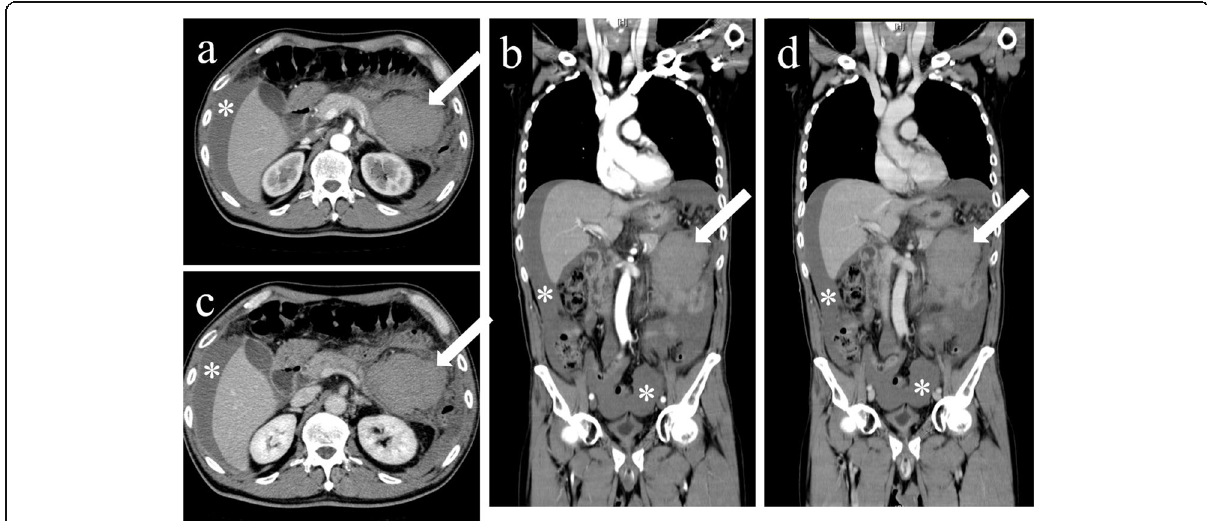
Fig. 2 A computed tomography with contrast on arrival at our emergency department is shown; a an axial section and b a coronal section in the early phase, and c an axial section and d a coronal section in the late phase. A non-enhanced, homogenous, 8.5 cm in diameter, high-density mass lesion is located between the posterior wall of the stomach and the anterior side of the pancreatic tail (arrows). There was no sign of